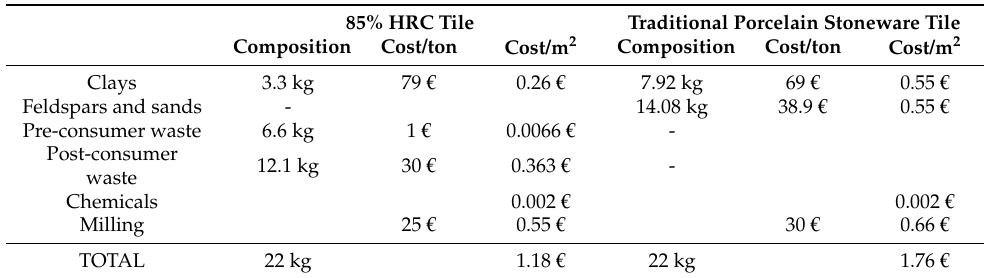
Table 8. Average costs to produce 1 m 2 of HRC mix and 1 m 2 of average mix of a traditional porcelain stoneware tile (the firing phase was not